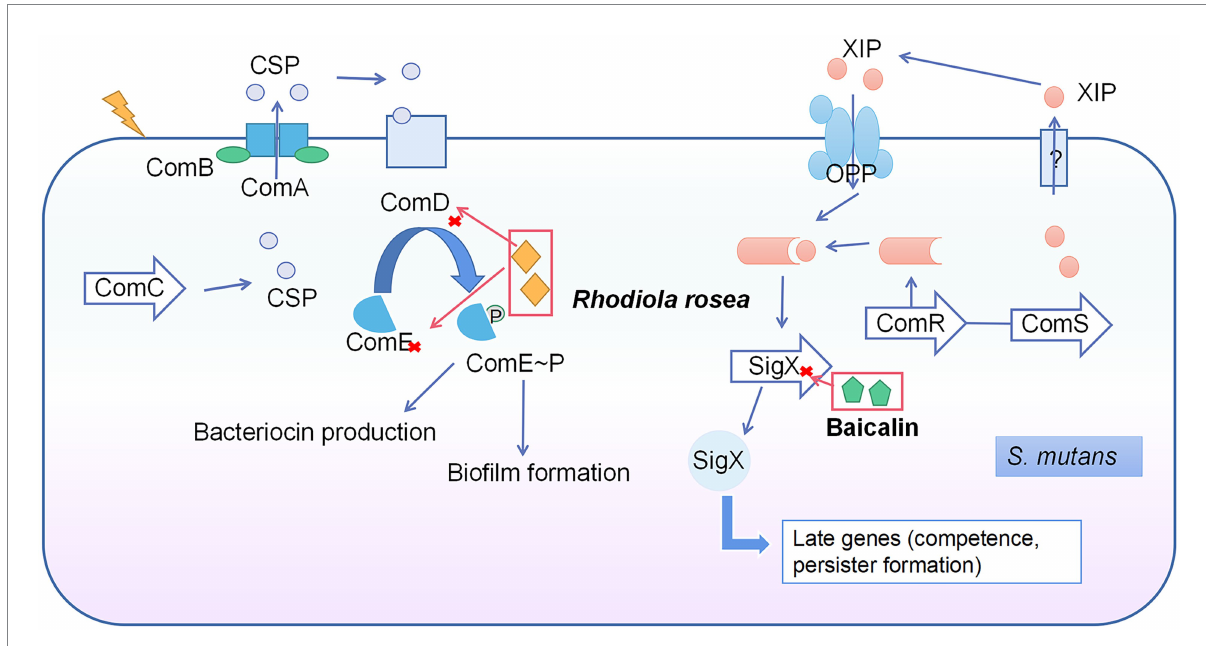
FIGURE 2 Quorum sensing system in S. mutans and the inhibitory effects of natural products on this system. The CSP-ComDE system is composed of a signal peptide (CSP, encoded by ComC) and the ComDE two-component system. During the cell density increase, the accumulated CSP interacts with ComD (membrane-bound histidine kinase receptor) directly to cause the phosphorylation and activation of ComE (the cytoplasmic response regulator). The activated ComE regulates the gene expression of bacteriocin production and biofilm formation. The ComRS system consists of signaling peptide pheromone (XIP, encoded by ComS) and a transcriptional regulator (ComR). The XIP interacts with and activates ComR to regulate the expression of ComX, and thus switches the genes related to competence and persister formation. Rhodiola rosea inhibited ComDE gene expression and baicalin inhibited ComX gene